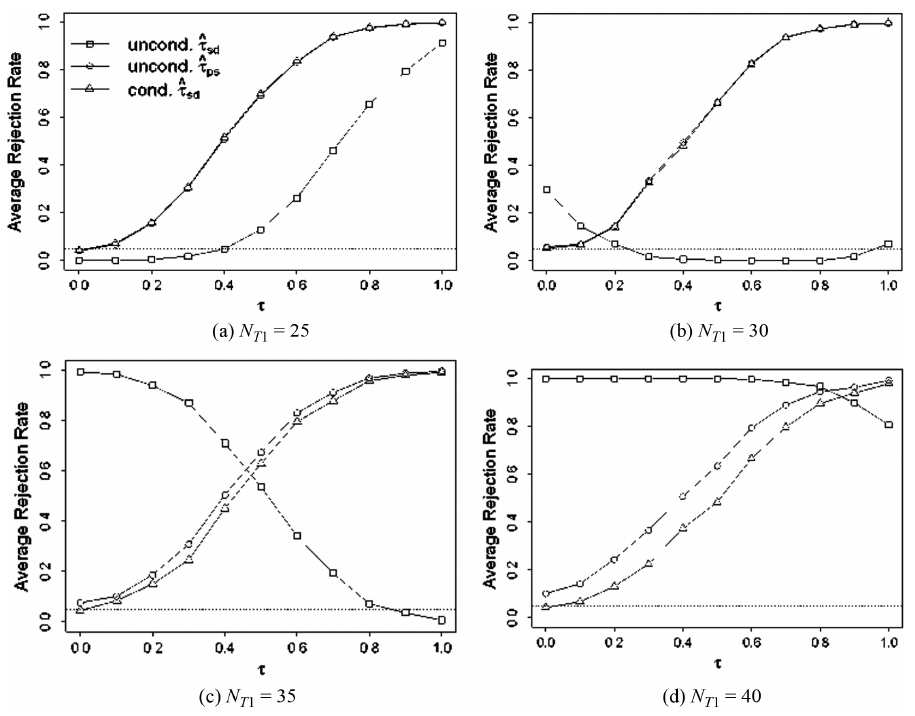
Figure 3: Conditional average rejection rates for different τ and N T 1 : In all simulations, λ =